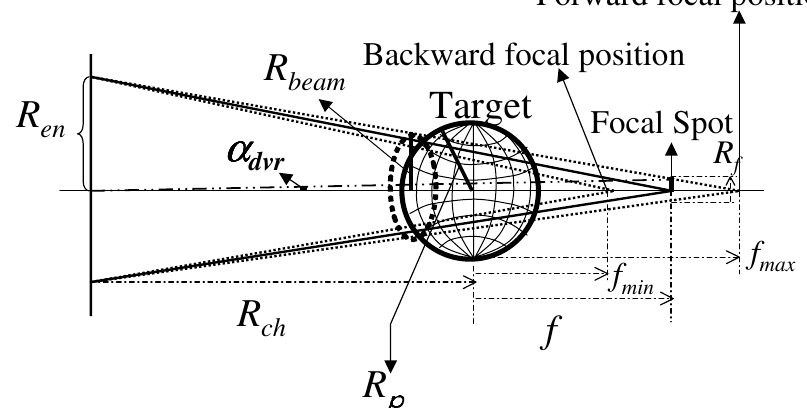
FIG. 3. The relationship between a beam emittance and the divergence angle at the beam port. R is the reactor radius, f is the beam focal spot, R fusion reactor, R ch is the beam radius in front of the divergence angle, and R beam